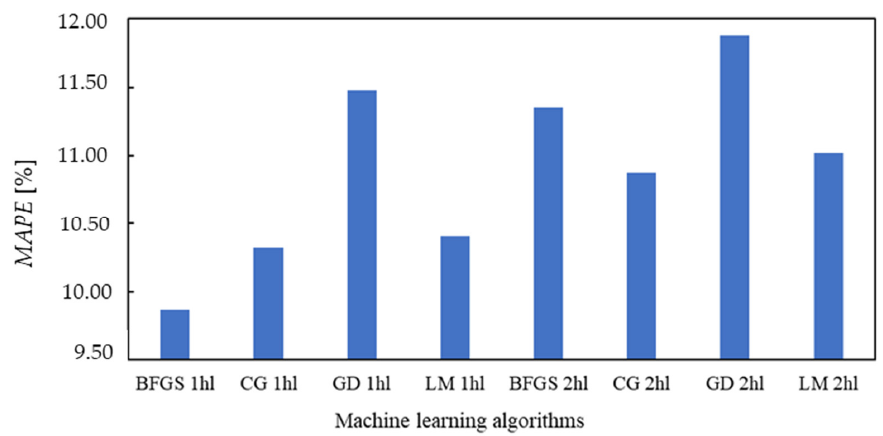
Figure 17. Comparison of models for predicting the pull-off strength of the surface layer f h due to the value of MAE .